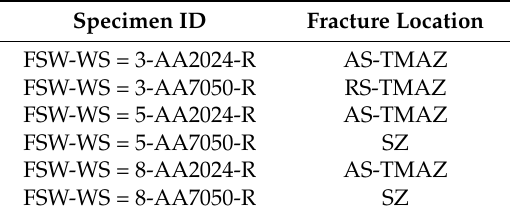
Table 5. Fracture location with changing WS and the material position.